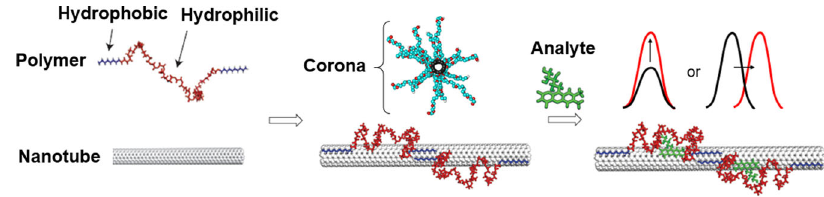
Fig. 7 Schematic of the CoPhMoRe concept. SWNTs are wrapped with a polymer that forms a “ corona ” which modulates analyte binding. Upon recognition of a molecule, SWNT fl uorescence changes in intensity or peak wavelength. Adapted with permission from ref. 28 .